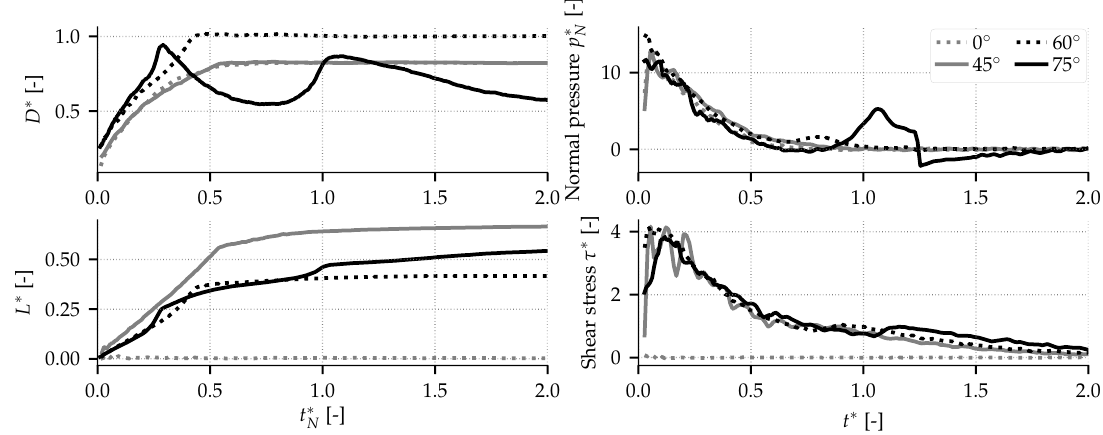
Figure 15. Influence of the impact angle on the transient of a cube presenting its edge perpendicular to the tangential velocity component.